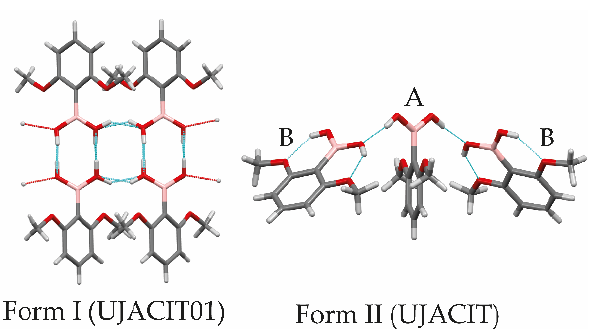
Figure 3. Hydrogen bonding in the crystal structures of MPBA polymorphs and labelling of molecules in Form II.